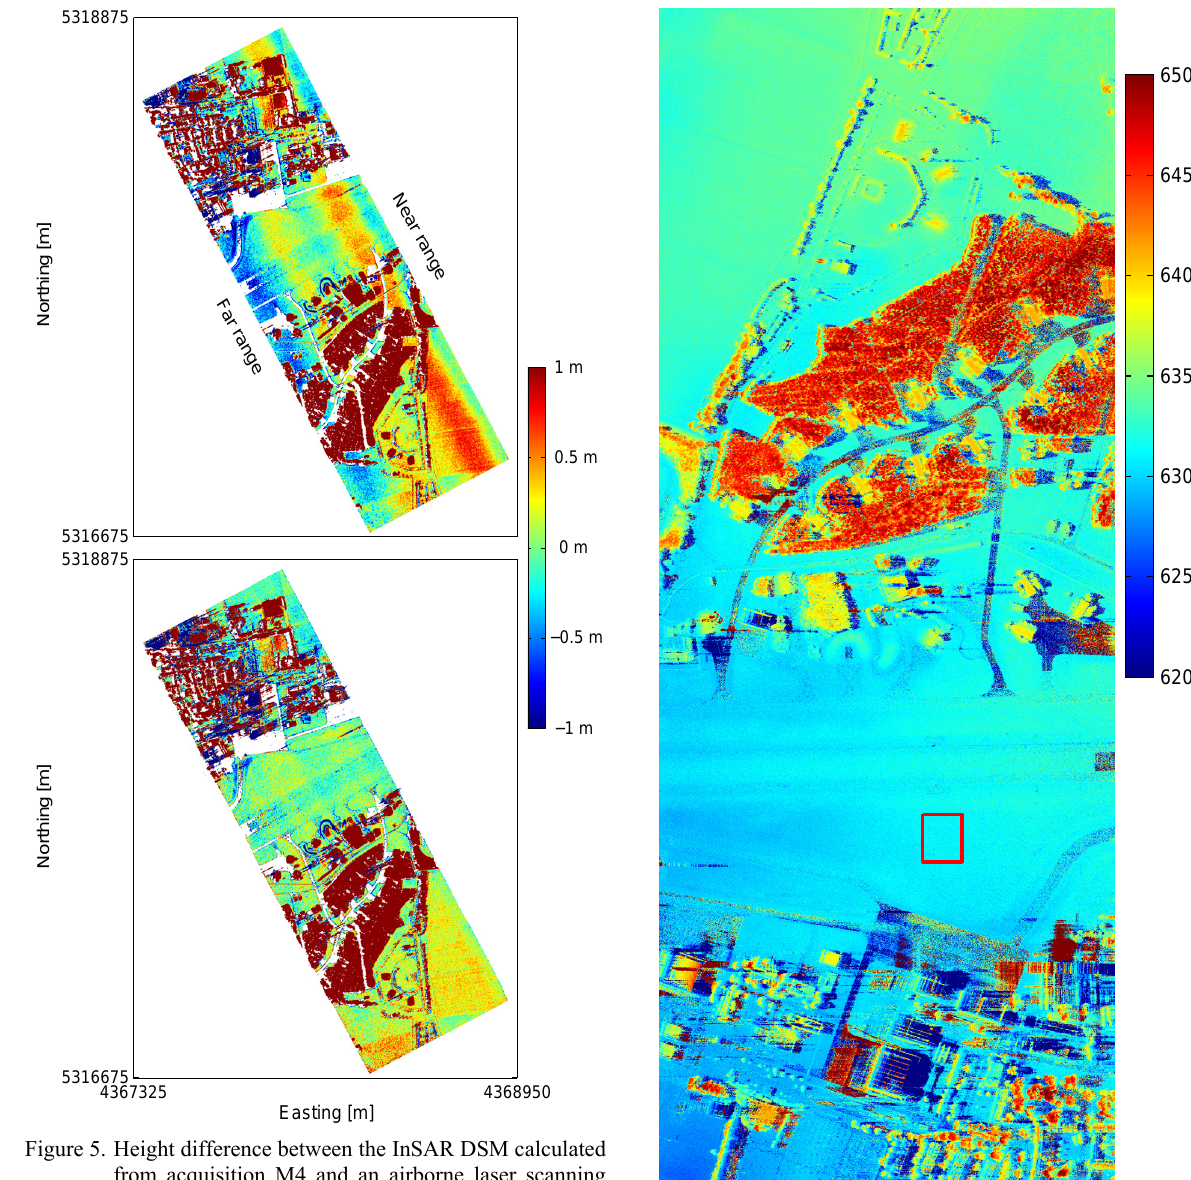
Figure 6. Height calculated through the ML InSAR processing for acquisition M4. The red rectangle shows one of the flat verification areas. The height standard deviation depends directly on the range distance, and is related to the local ambiguity height. The heights were first converted back into phase values to aggregate the data from various range distances. Histograms of the phase were generated and normal distribution curves were fit to these histograms, as shown in Figure